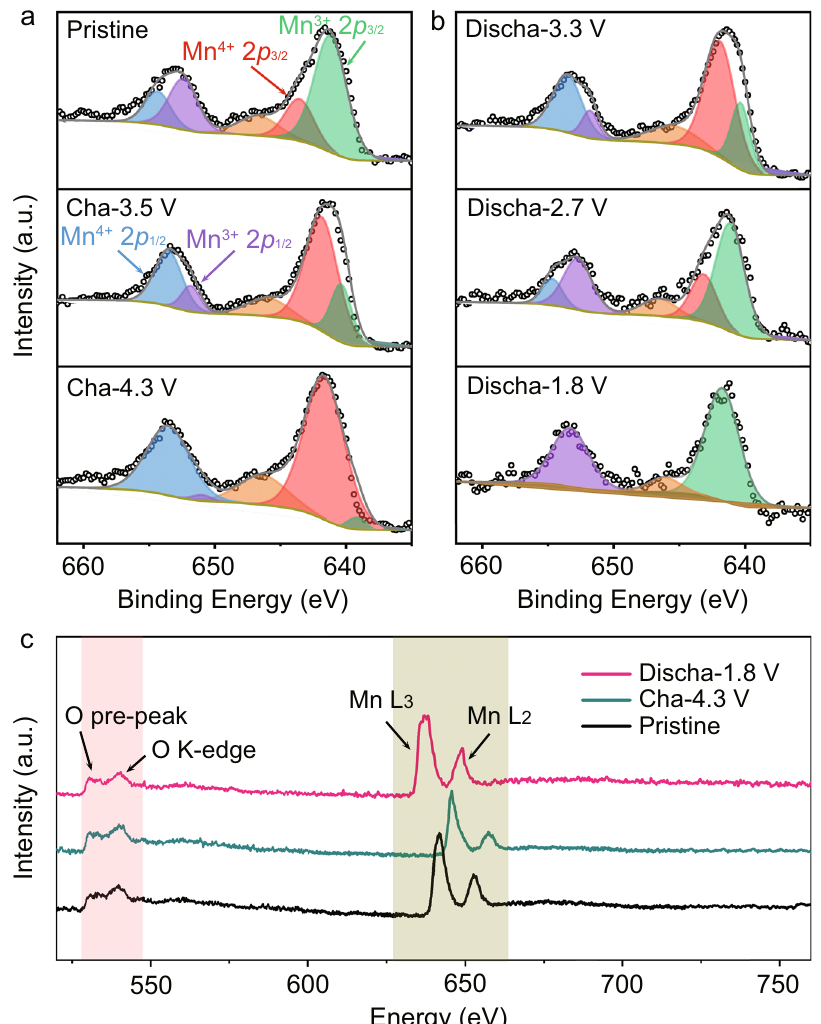
Fig. 4 Valence evolution during charge and discharge of Na 0.612 K 0.056 MnO 2 . XPS Mn 2 p spectra at the charge ( a ) and discharge ( b ) states. c EELS spectra at different states of Na 0.612 K 0.056 MnO 2